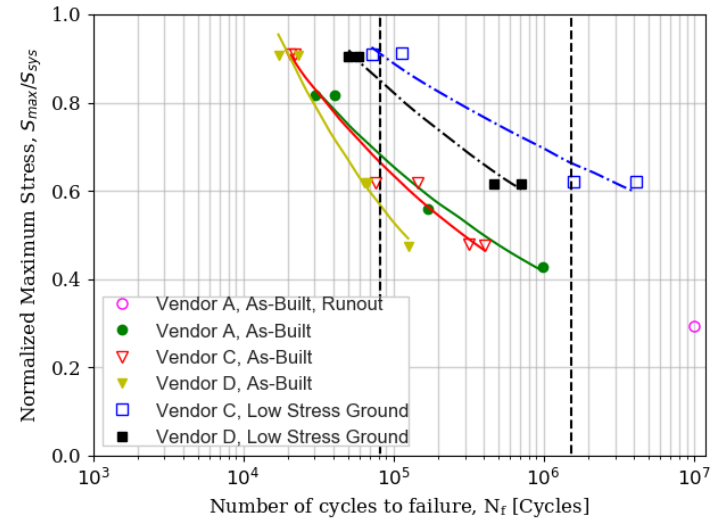
Figure 35: Fatigue results comparing low stress ground and as-built specimen of SLM IN718 [81].  Internal